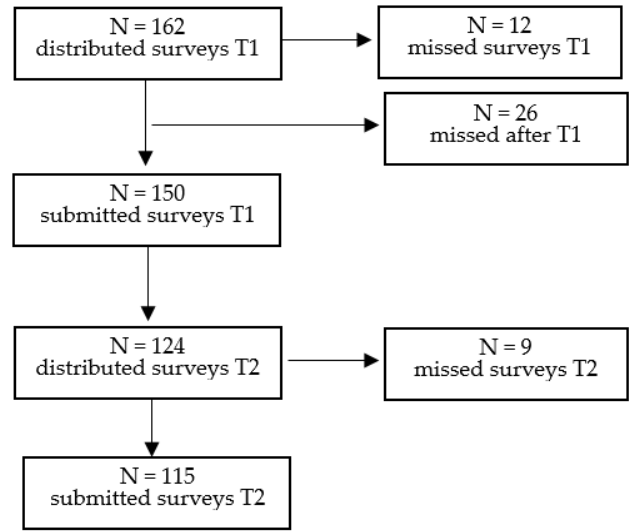
Figure 1. Process of study selection.